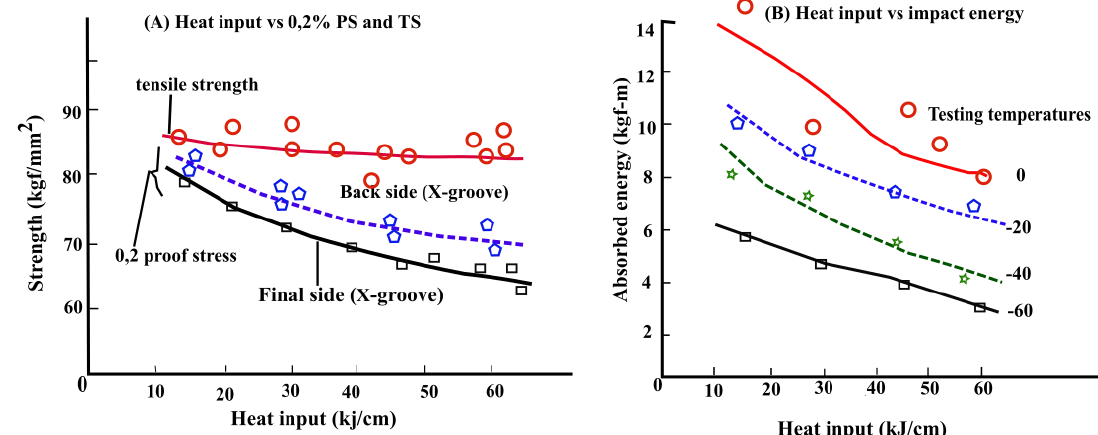
Figure 15: (a) Heat input with strength behavior of 780 MPa (80 kgf/mm 2 ) using SMAW (1 kgf/mm 2 = 9.8 MPa; 1 kgf-m = 9.8 J). Reprinted with permission from Ikawa et al. // Sampo Publication Inc, (1978). © 1978 Sampo Publication